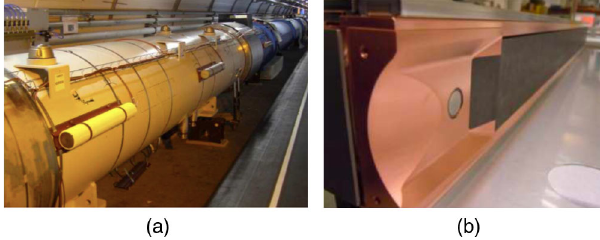
FIG. 3. (a) BLM detectors installed in the LHC and (b) BPM detectors installed in collimator